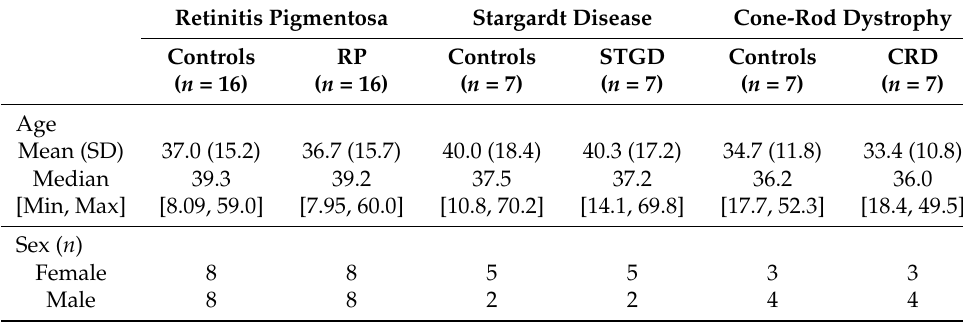
Table 1. Demographic information for RP, STGD, and CRD patients and